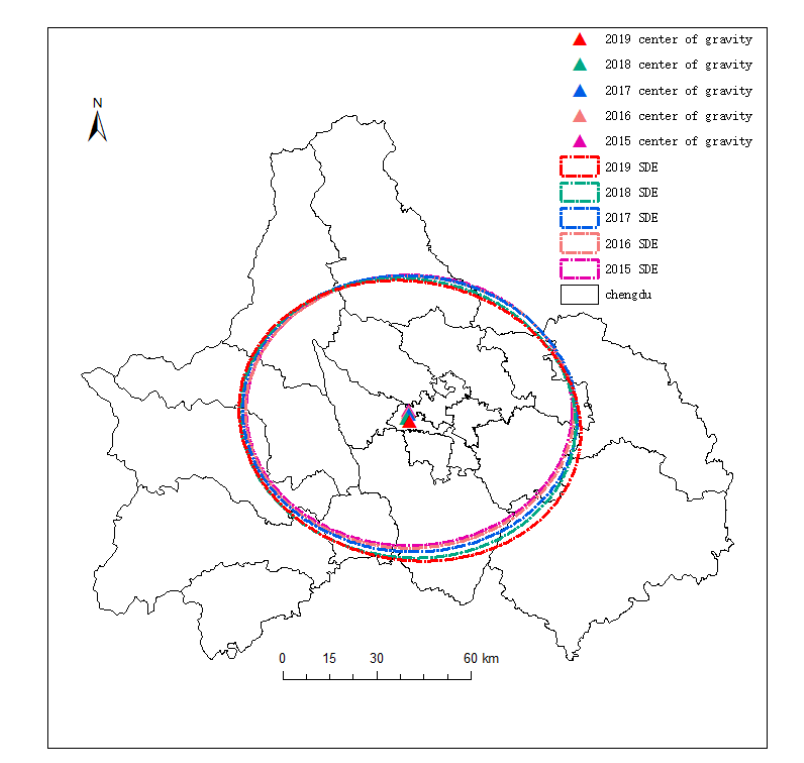
Figure 7. Standard Deviation Ellipse data of the urban built-up area in Chengdu.